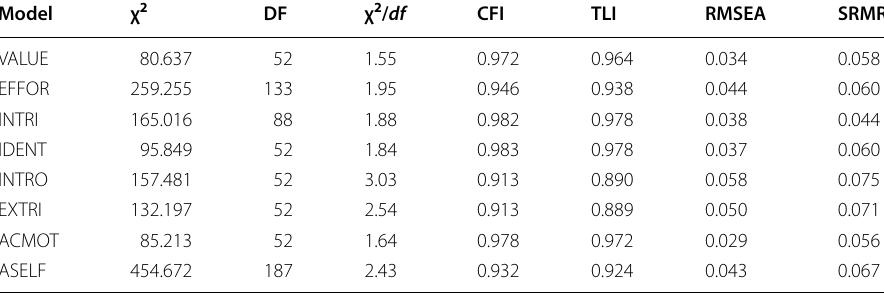
Table 9 Model fit indices for univariate STMS